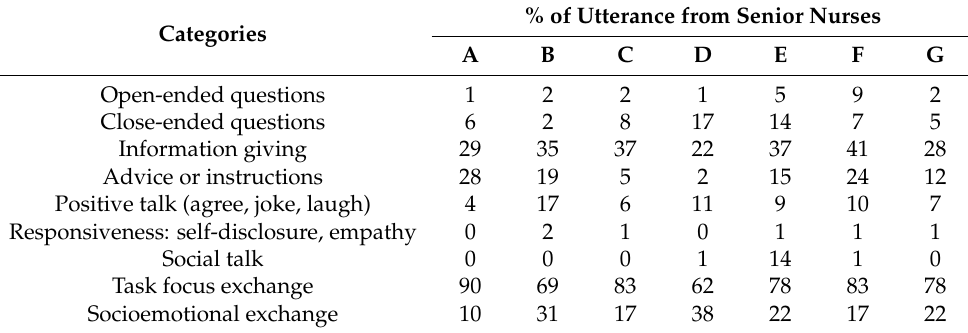
Table 5. Percentage of utterances of senior nurses (%).